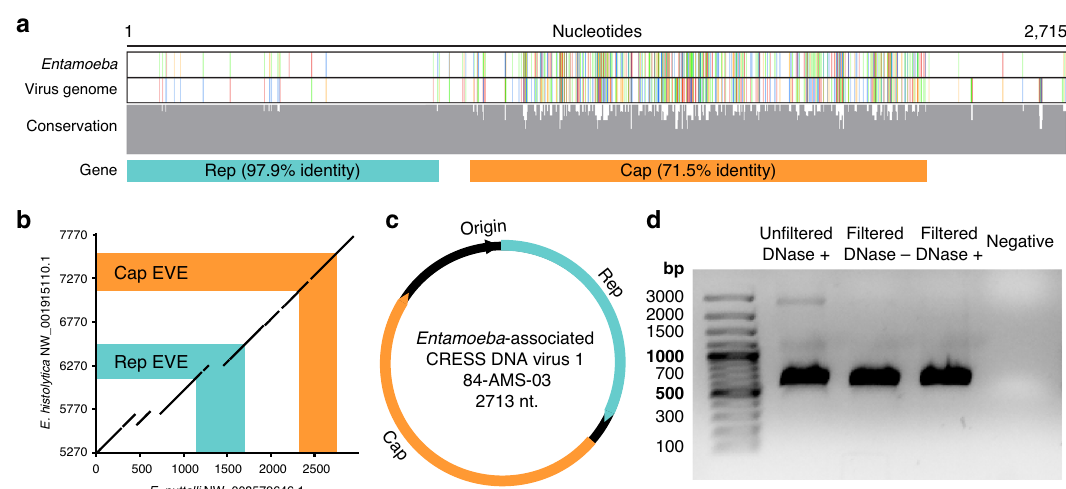
Fig. 1 Whole CRESS virus genomes are integrated in Entamoeba genomes. a Cropped nucleotide alignment between Entamoeba dispar contig (AANV02000527.1) containing a complete virus integration and the genome of Entamoeba -associated CRESS DNA virus 1, isolate 84-AMS-03 (accession MT293413.1); also see Supplementary Fig. 2. Coloured vertical bars denote single nucleotide variations between the sequences (adenine = green, guanine = red, thymine = blue, cytosine = orange), with conservation across the alignment displayed below. b Dotplot of BLAT generated nucleotide alignment between endogenous viral elements and fl anking sequence from two closely related Entamoeba species ( x -axis sequence reverse complemented). c Example of the circular genome organisation of identi fi ed CRESS viruses. d Exogenous virus DNA is protected by a viral capsid, as it can be PCR-ampli fi ed after fi ltration and treatment with DNase (one independent